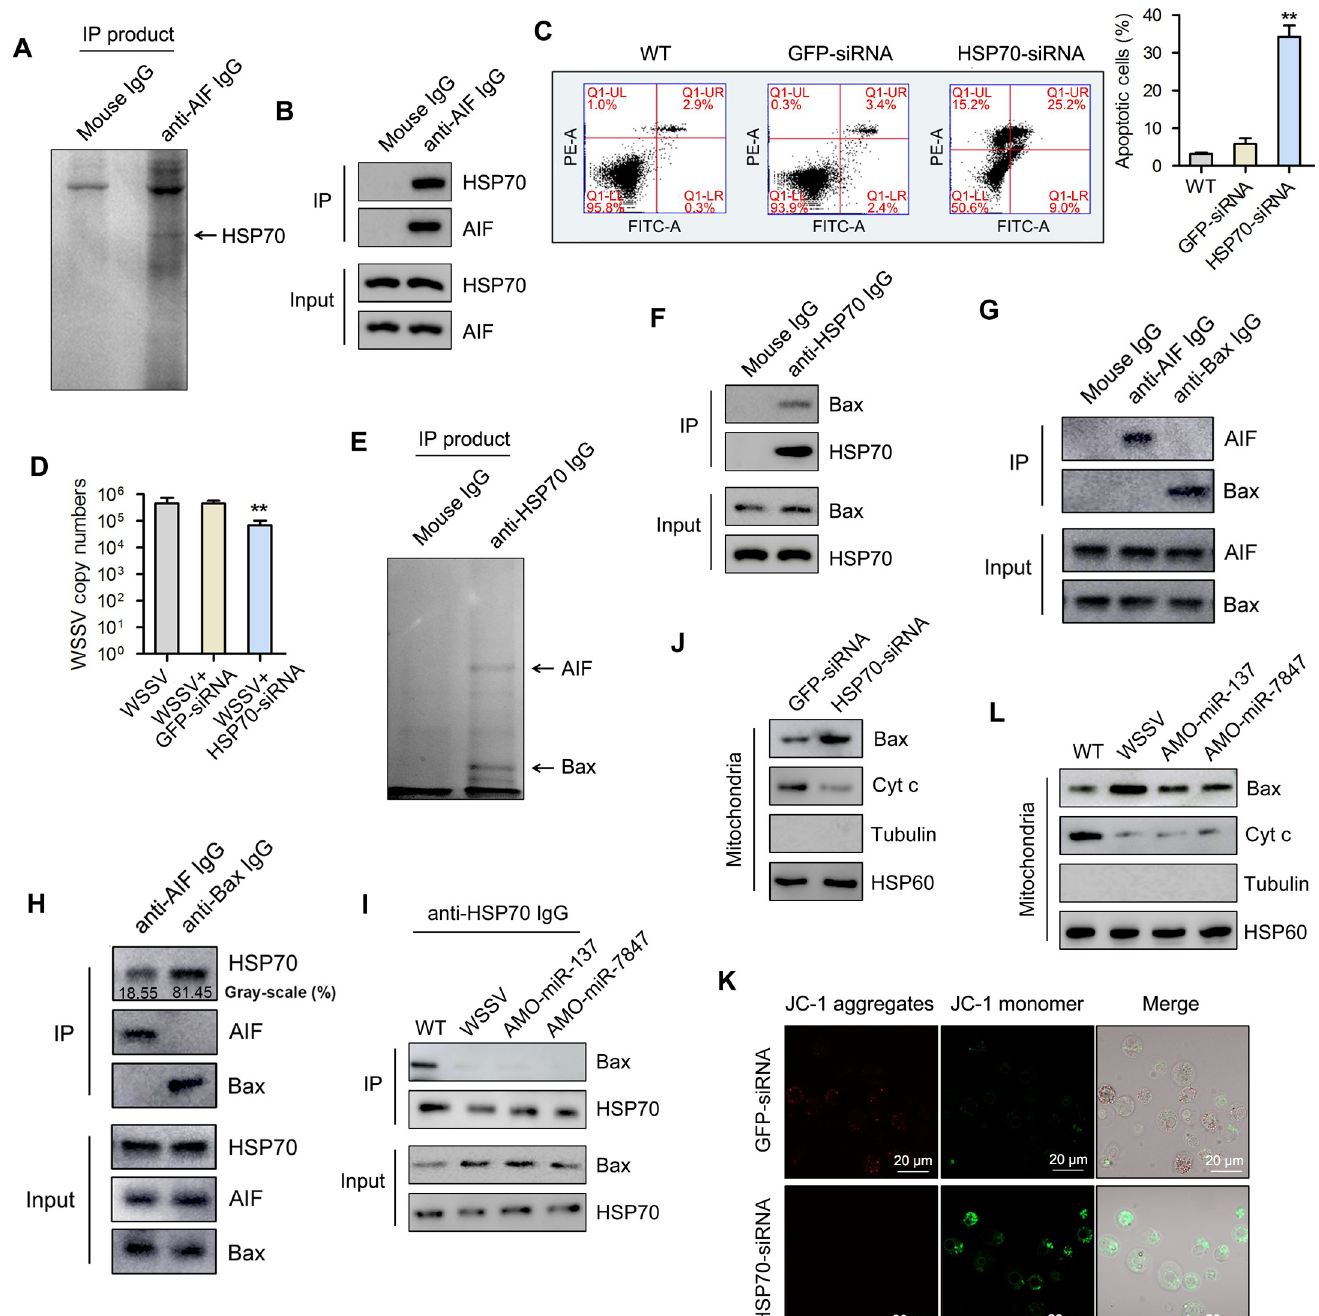
Fig 7. Underlying mechanisms of AIF-mediated mitochondrial apoptosis process. (A) Identification of proteins bound to AIF. The cell lysates of mud crab hemocytes were subjected to Co-IP assay using anti-AIF IgG, then the IP products were separated with SDS-PAGE and identified by mass spectrometry. (B) The interactions between AIF and HSP70 in mud crab, the cell lysates were subjected to Co-IP assay with anti-AIF IgG, then the IP products were subjected to Western blot analysis to detect HSP70. (C) The effects of HSP70 silencing on apoptosis regulation, HSP70-siRNA or GFP-siRNA were injected into mud crab for 48 h, then the hemocytes were subjected to annexin V assay. (D) The influence of HSP70 silencing on WSSV infection in mud crab. (E) Identification of proteins bound to HSP70, the proteins identified were indicated with arrows. (F) The interactions between HSP70 and Bax in mud crab, the cell lysates were subjected to Co-IP assay with anti-HSP70 IgG, then the IP products were subjected to Western blot analysis to detect Bax. (G) The interactions between AIF and Bax in mud crabs. Cell lysates were subjected to Co-IP assay with anti-AIF IgG and anti-Bax IgG, and the Co-IP products subjected to Western blot analysis to detect AIF and Bax. (H) The percent of HSP70 that binds to AIF and Bax. Cell lysates were subjected to Co-IP assay with anti-AIF IgG and anti-Bax IgG, followed by analyzing the Co-IP products by Western blot and Gray-scale sensitometry quantification using Image J software. (I) The interactions between HSP70 and Bax in mud crab with the